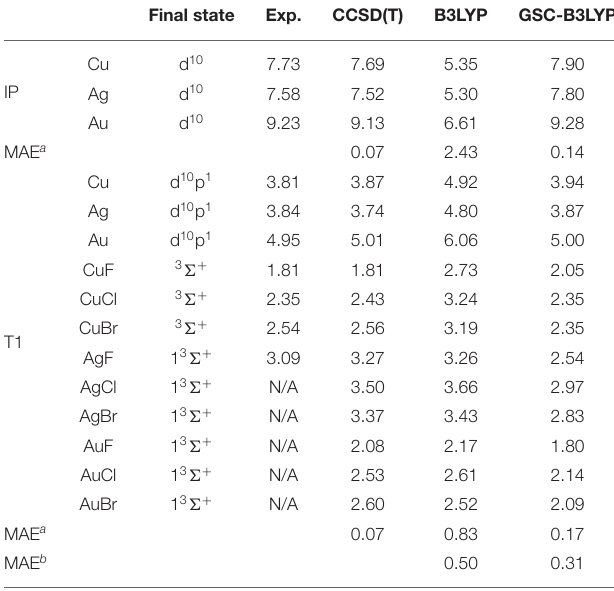
TABLE 1 | Calculated and experimental ionization potentials (IPs) and T1 excitation energies of various transition metal atoms and